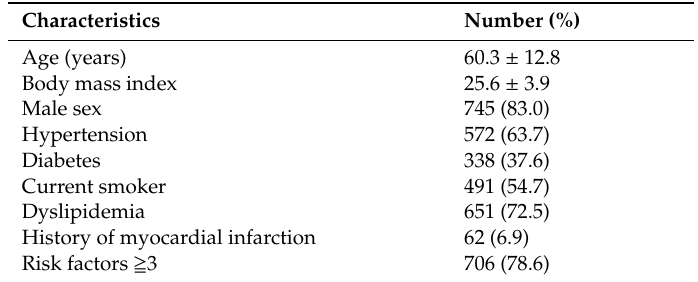
Table 1. Demographic characteristics of patients ( n = 898).